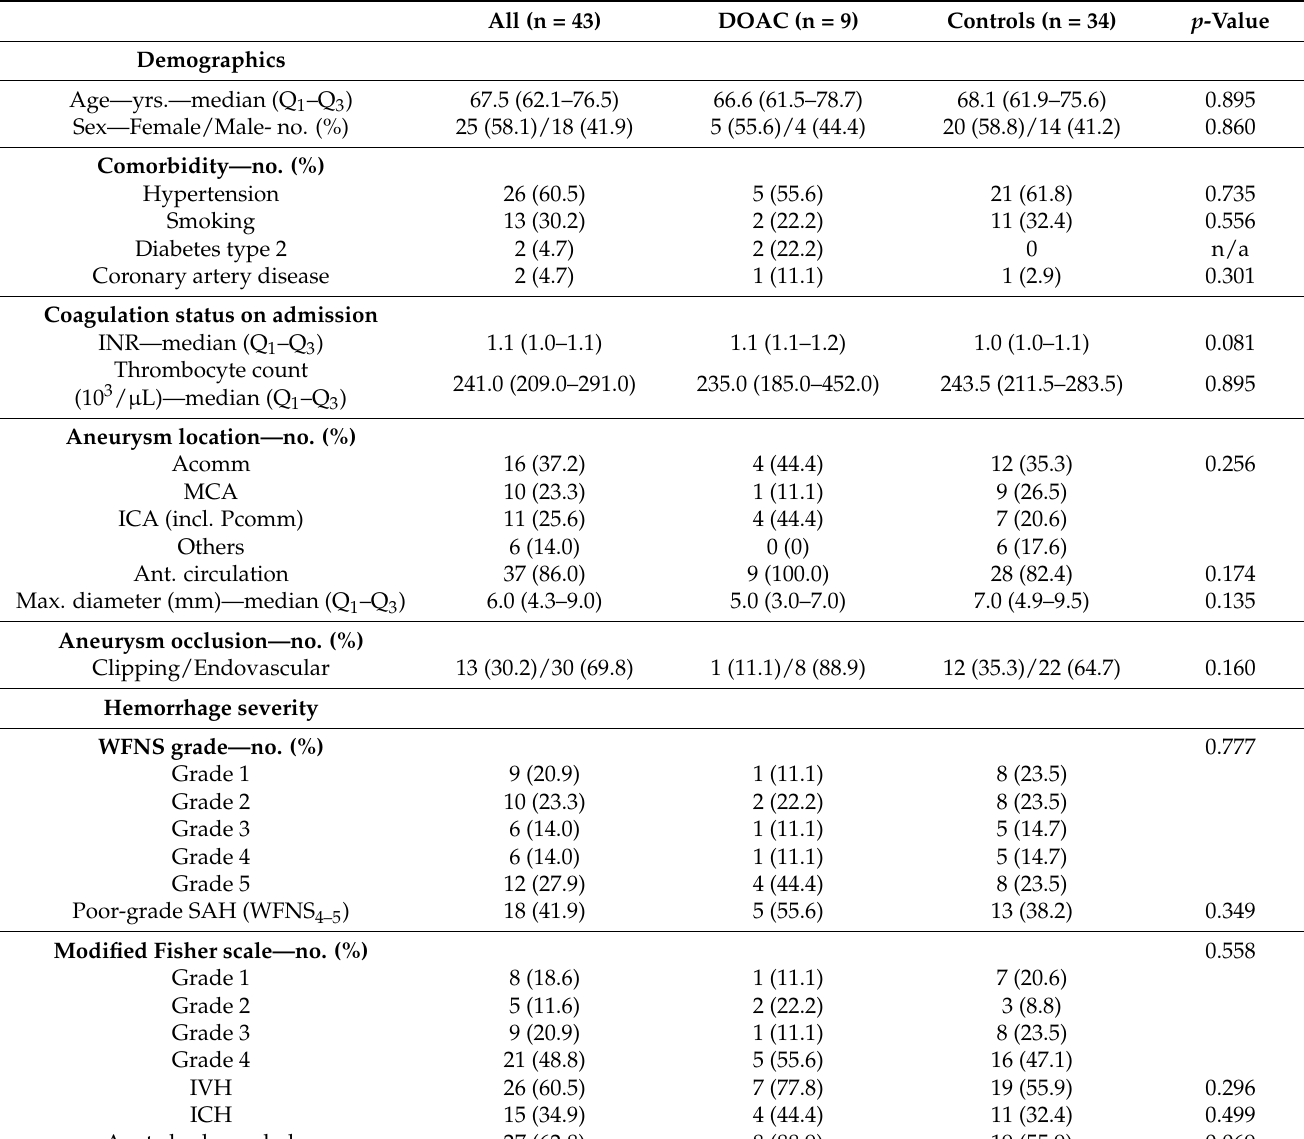
Table 1. Comparison of patients on direct oral anticoagulants (DOAC) with age- and sex-matched controls without antithrombotic